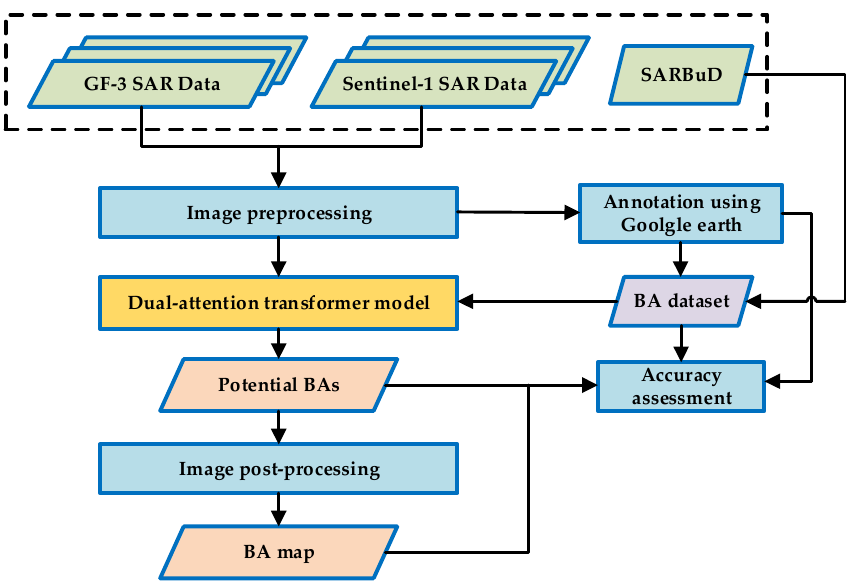
Figure 1. The framework of the proposed method.